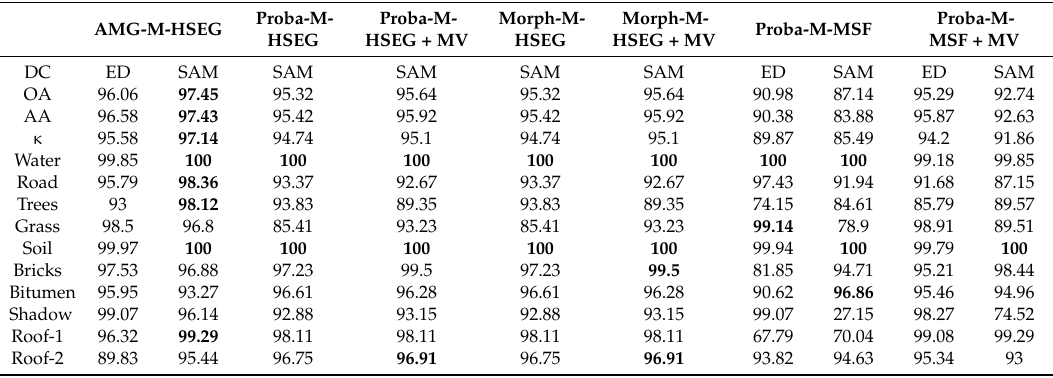
Table 4. The GAs and CAs (percent) for the center of the Pavia image using all the spectral-spatial classification methods for comparison. The highest accuracies are indicated in bold in each category.